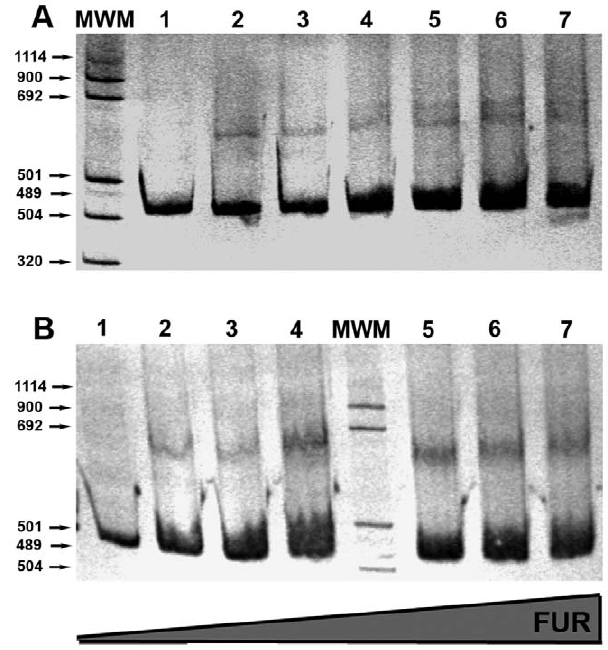
Figure 6. Fur binding to nrdHIEF . EMSA of ( A ) nrdHIEF and ( B ) fur promoter region probes of S. Typhimurium LT2, with increasing concentrations of Fur protein: 1–7 lanes: 0, 0.2, 0.4, 0.8, 1, 1.2, and 1.5 m g. MWM: molecular weight marker.